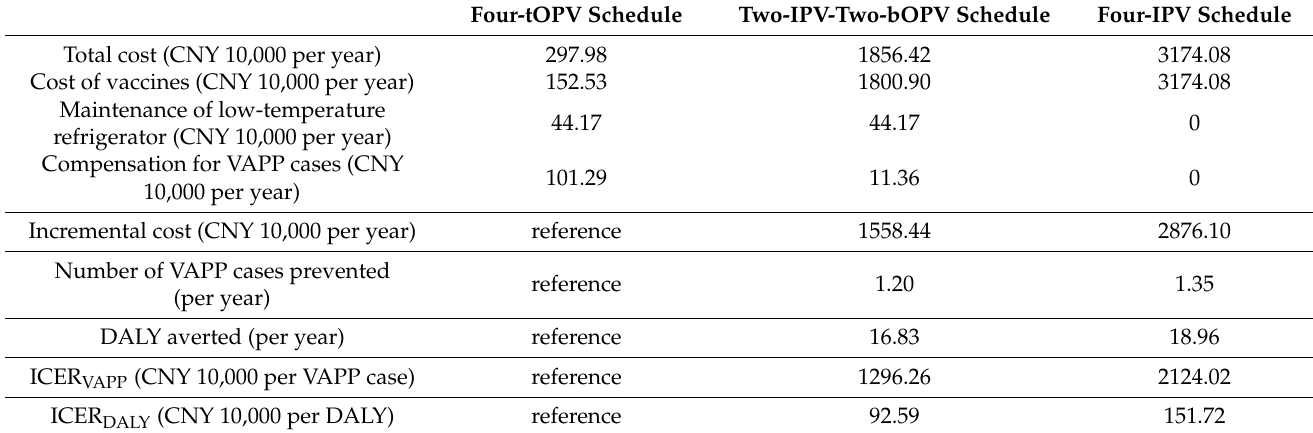
Table 2. Total cost and effectiveness of three polio immunization schedules.